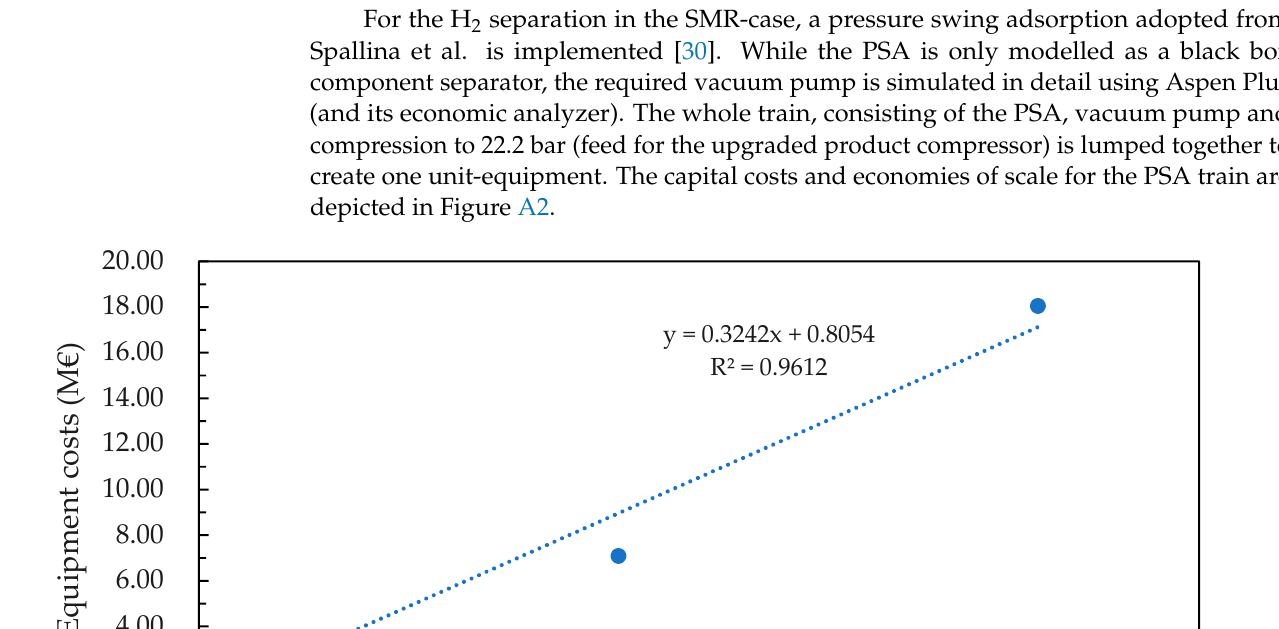
Figure A1. Equipment cost function for compressor of upgraded SynFeed (H 2 /CO 2 = 3) from 0.9 bar to 22.2 bar.